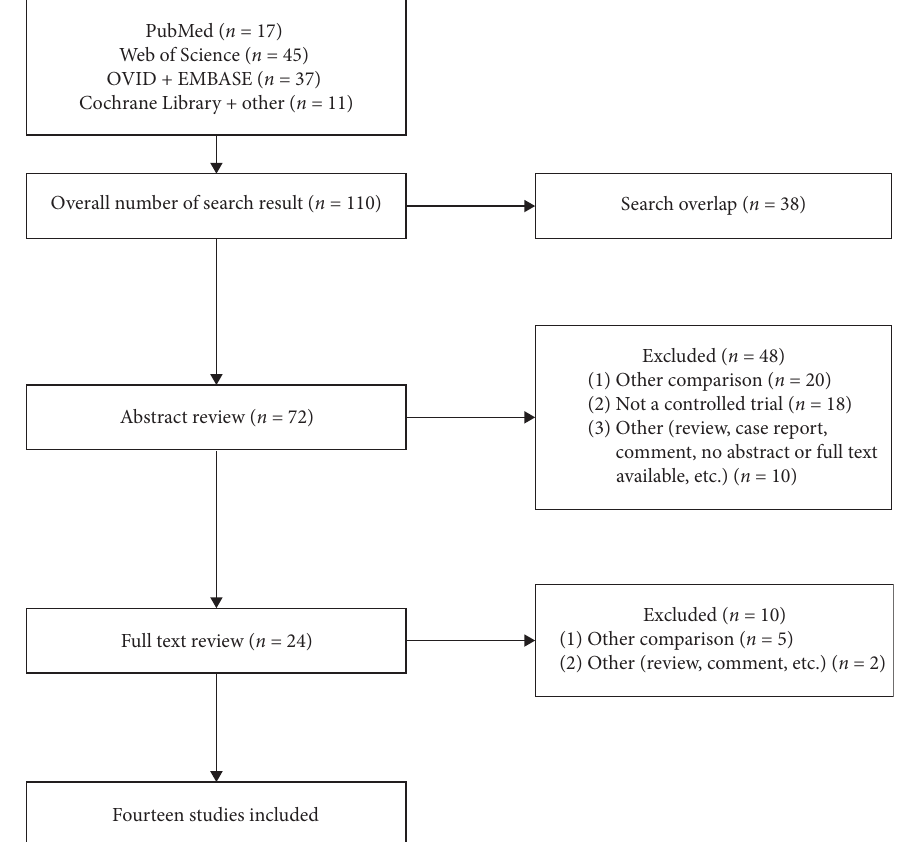
F IGURE 1: Flow diagram of study screening and